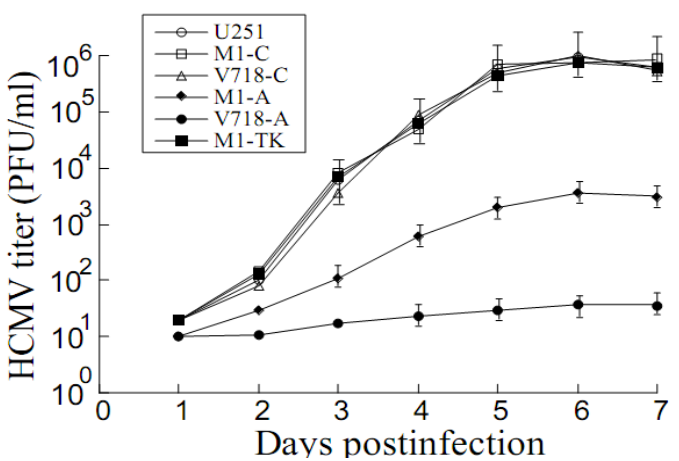
Figure 5. HCMV growth in U251 cells and M1GS-expressing cell lines. Experiments were carried out in triplicate, and repeated three times. Values are means of these experiments and the standard deviation is indicated by the error